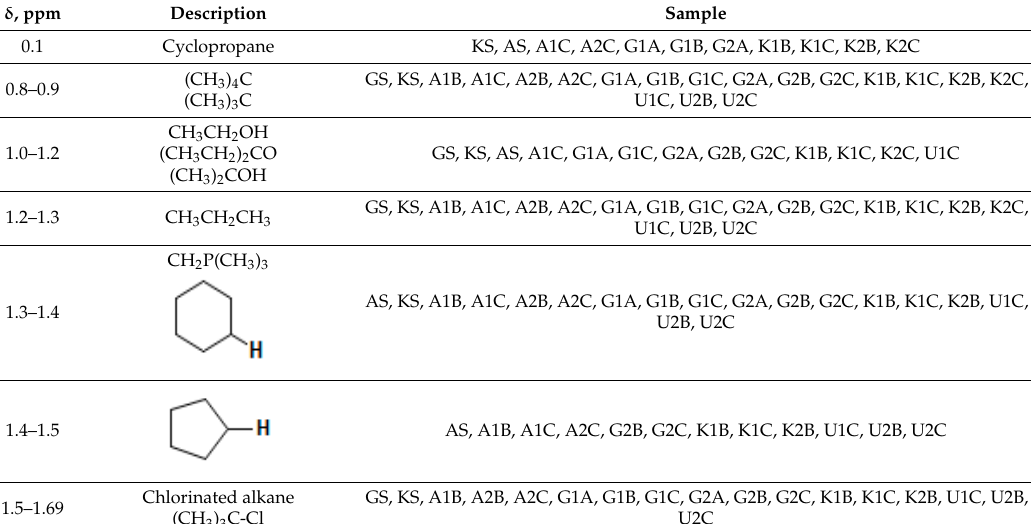
Table 2. 1 H-NMR chemical shifts (relative to TMS at δ = 0) of wastewater, treated effluents and sludge samples. The shifting proton is bold.